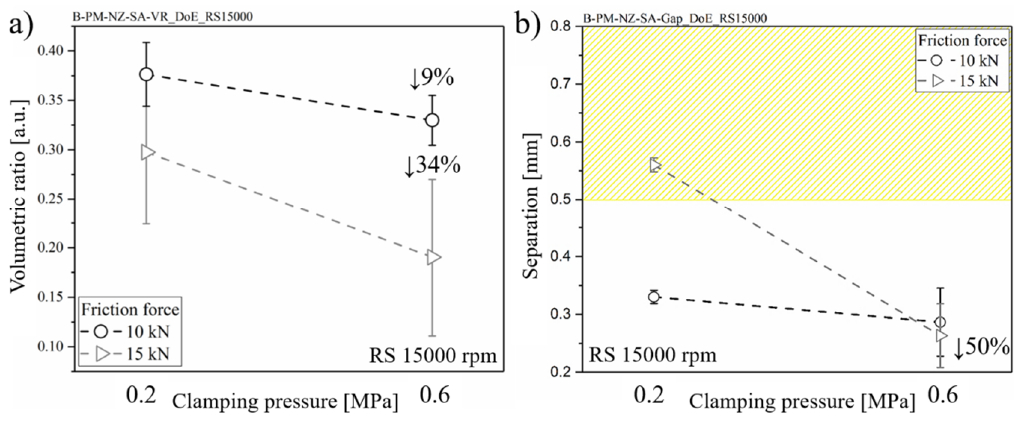
Figure 13. Effect of the clamping pressure on the ( a ) volumetric ratio and ( b ) separation of the composite parts. The hatched upper area in (b) represents the usual range of the sealant and adhesive thickness used for hybrid bolted-bonded joints in aircraft structures [42–44].